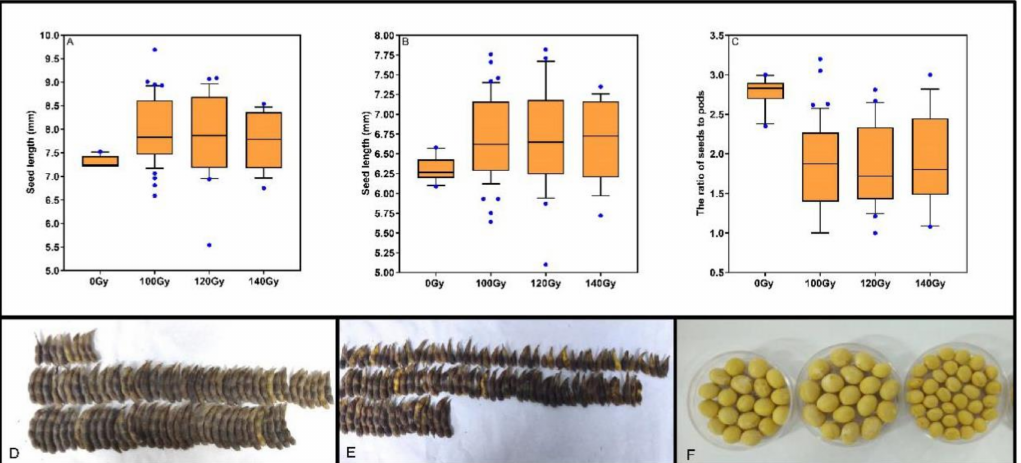
Figure 4. Distributions of seed length, seed width and ratio of seeds to pods in the M1 population. ( A ) Seed width; ( B ) seed length; ( C ) ratio of seeds to pods; ( D ) pods of WT; ( E ) pods of mutants with more one- and two-seed pods; ( F ) mutants with altered seed sizes (from left to right: WT, lager seeds mutant, smaller